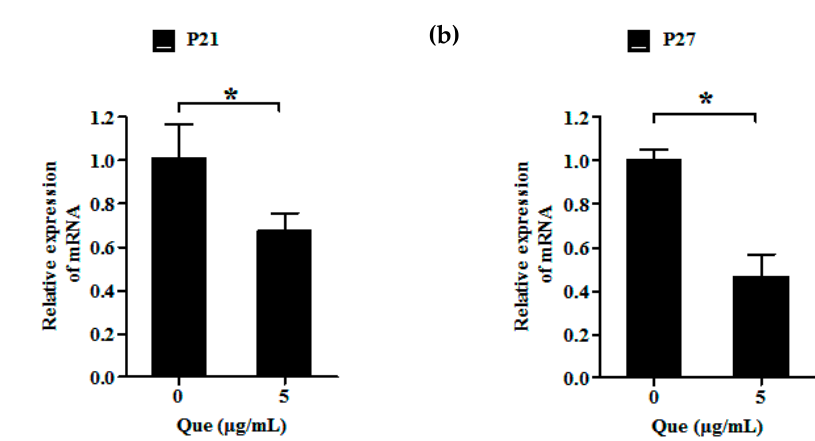
Figure 2. Effects of Que on mRNA relative expression level of P21 and P27 of IPEC-J2. ( a ) Relative expression level of P21 of IPEC-J2. ( b ) Relative expression level of P27 of IPEC-J2. Data are presented as mean ± SD. * p < 0.05 means significant difference between two groups.